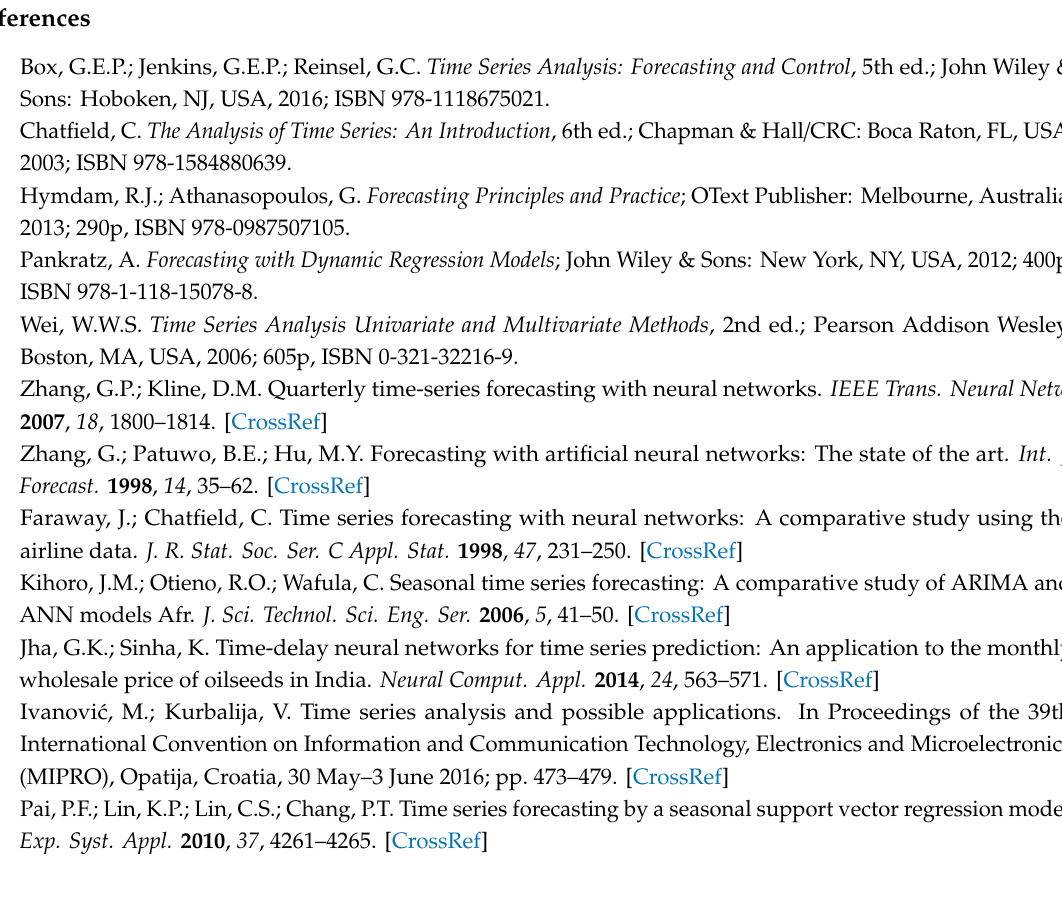
Table A2. Classification of the heat wave health hazard levels based on HI values (NWS-NOAA, 2). Alert Level Heat Index Possible Heat Disturbances for Vulnerable People Caution Extreme